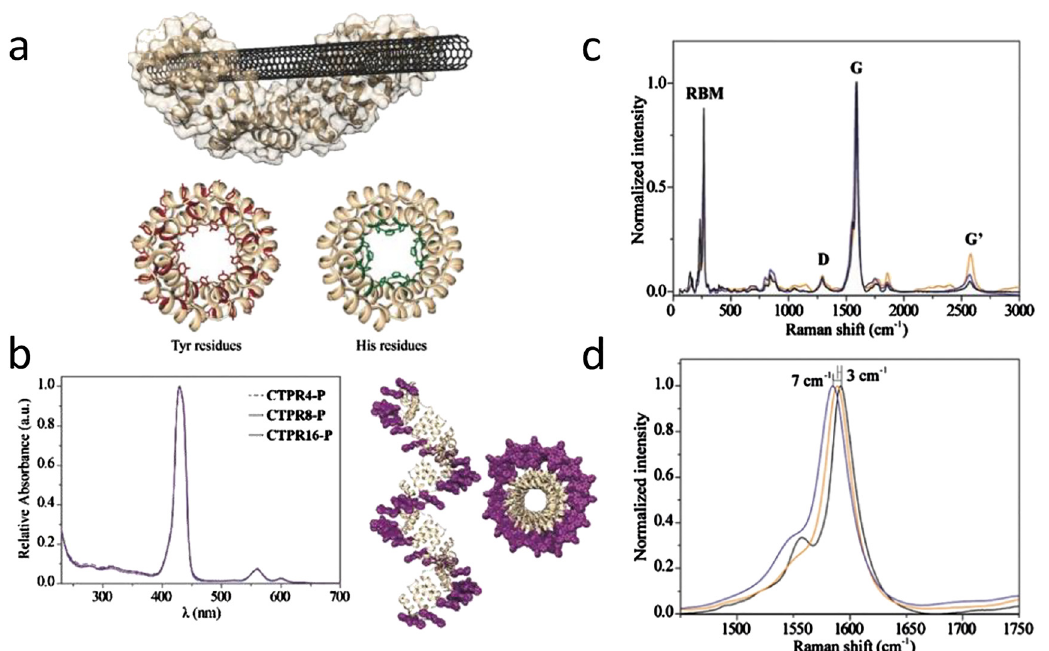
Figure 3: (a) Model morphology of the CTPR8/SWCNT(7, 6) hybrid with an axial view of the Tyr residues (red) and the His residues (green), (b) normalized UV – vis spectra of the conjugates CTPR4 ‐ P, CTPR8 ‐ P and CTPR16 ‐ P with presentation of CTPR16 ‐ P from different views, (c) Raman spectra of pristine SWCNTs (black), CTPR16/SWCNT (yellow), CTPR16 ‐ P/SWCNT (purple) after excitation at 785 nm, (d) normalized Raman spectra in the region of the G ‐ mode [31]. SWCNT, single-wall carbon